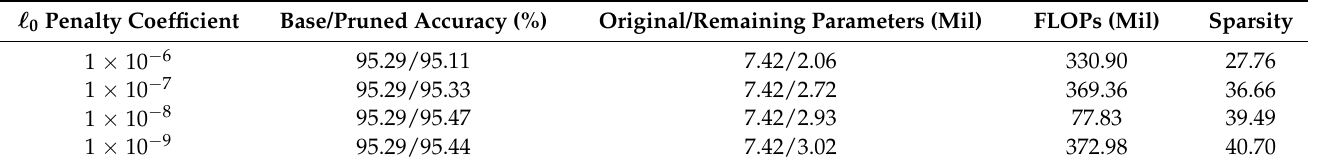
Table A8. The effect of the coefficient of (cid:96) 0 norm penalty on ResNet-32. (cid:96) 0 Penalty